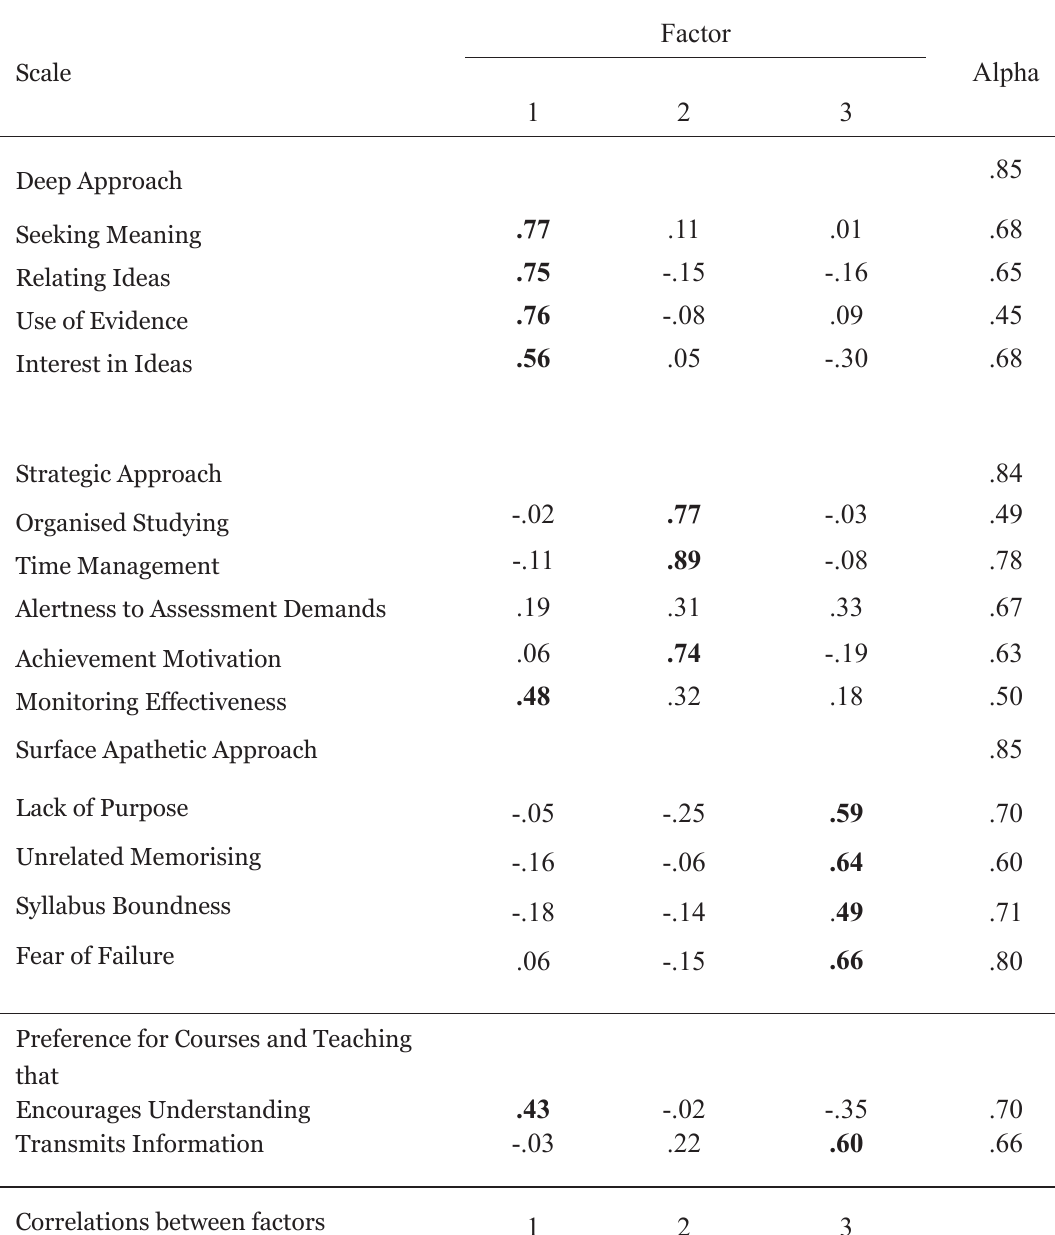
Table 1 Factor Loadings and Cronbach Alpha for ASSIST Subscales and Correlations between